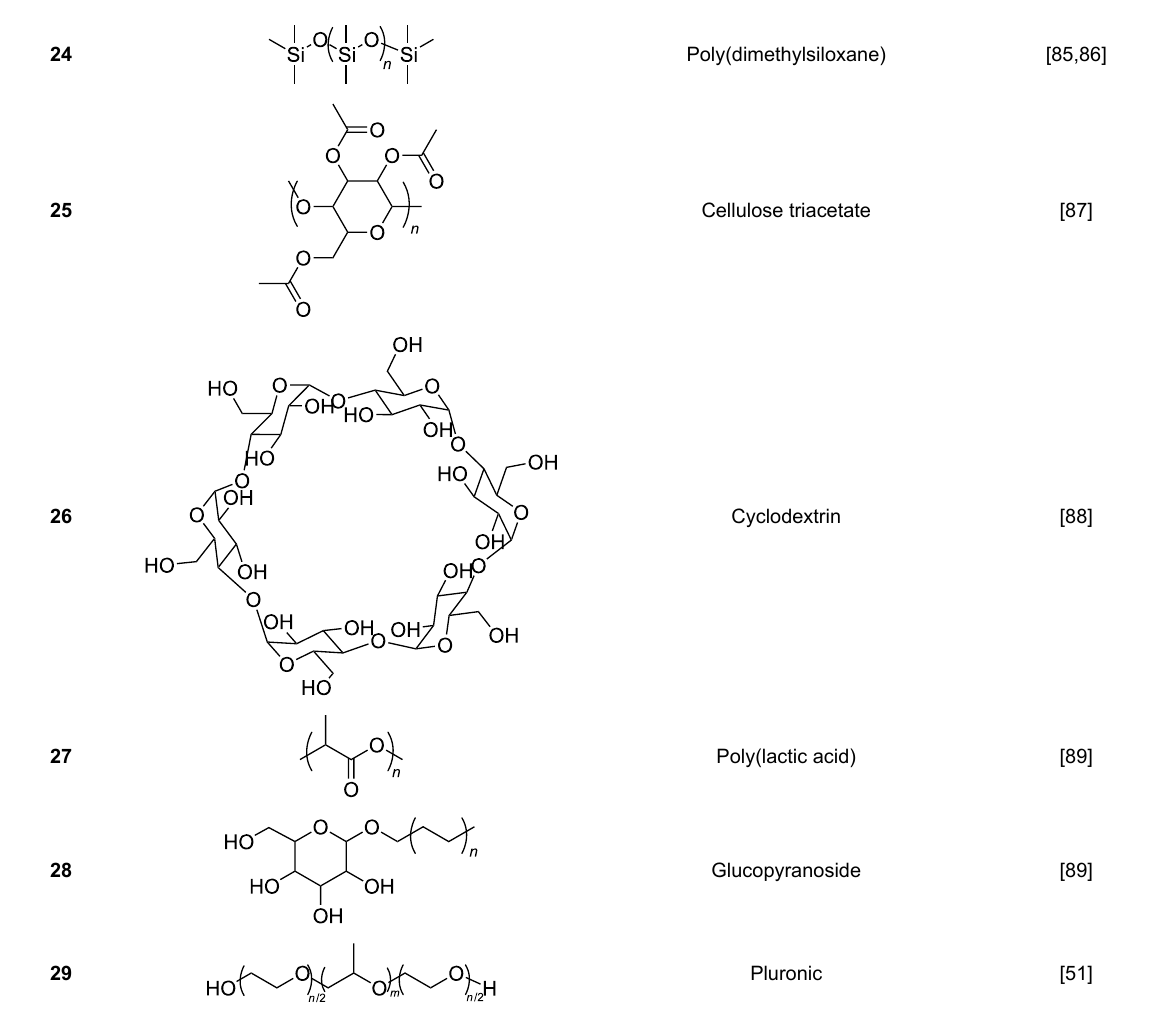
Table 2: Structures of CO 2 -philic polymers discussed in this review.